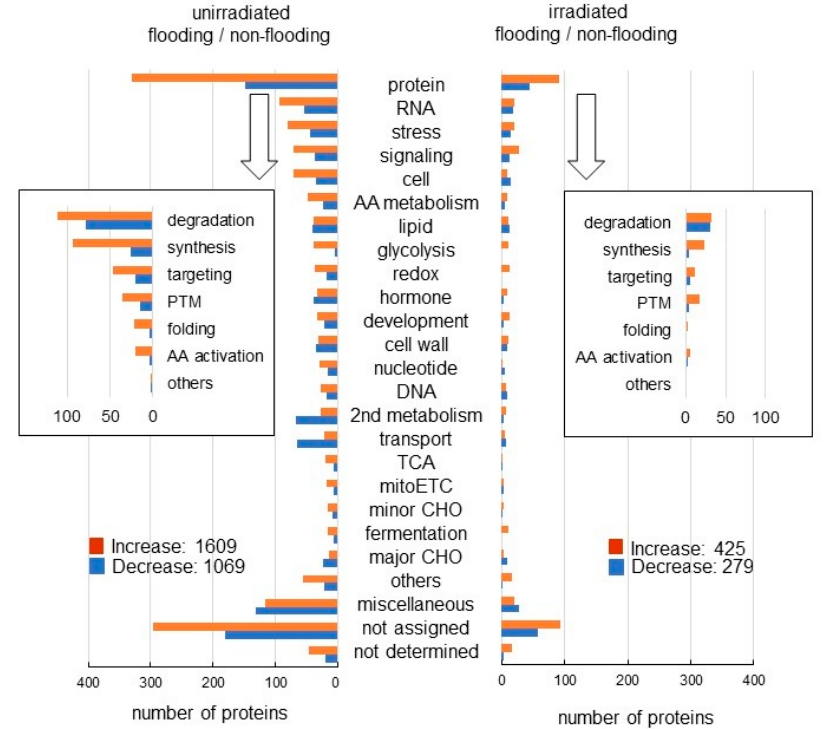
Figure 3. Functional categories of proteins with differential abundance in wheat irradiated with or without millimeter waves under flooding stress. Wheat seeds were irradiated without (unirradiated) or with (irradiated) 20 mW millimeter waves for 20 min and exposed without (non-flooded) or with (flooded) flooding stress. Non-flooded and flooded samples were collected from both unirradiated group and irradiated group. After proteomic analysis, functional categories of significantly changed proteins ( p < 0.05) from flooding/non-flooding wheat without or with irradiation were determined using MapMan bin codes (Tables S4 and S5). Orange color indicates “increased proteins” and blue color indicates “decreased proteins” under flooding stress compared with non-flooding stress. Abbreviations: mitoETC, mitochondrial electron transport chain; TCA, tricarboxylic acid cycle; PTM, post-translational modification; and AA, amino acids. “not assigned” indicates proteins without ontology or characterized functions.